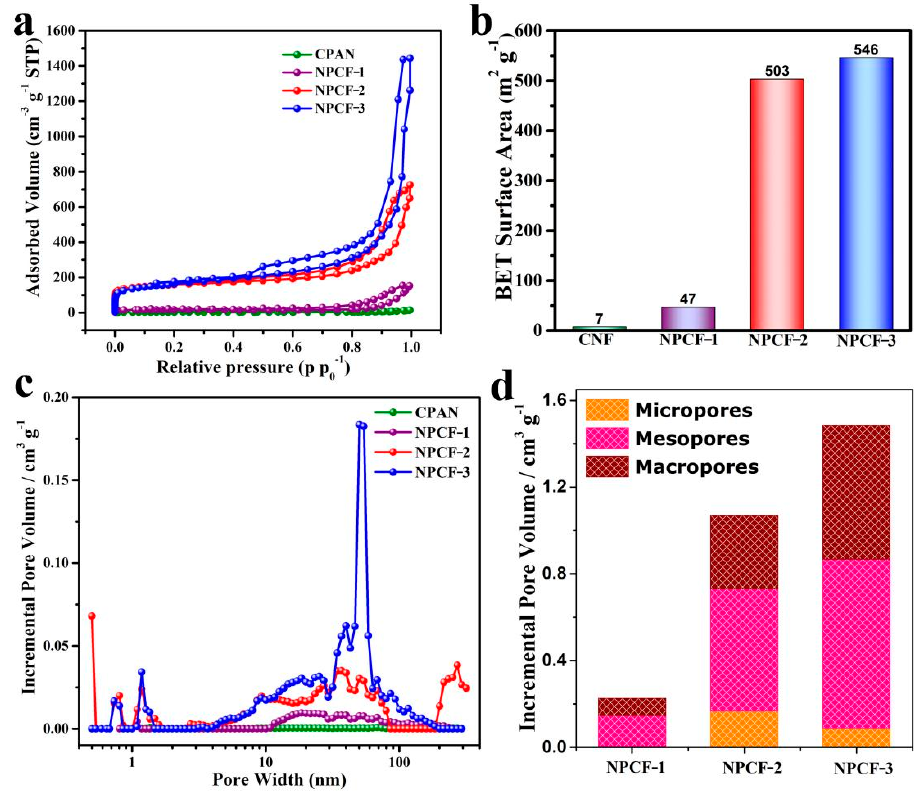
Figure 2. Nitrogen adsorption-desorption isotherms ( a ), BET surface area values ( b ) and DFT pore size distributions ( c , d ) of different NPCFs and CPAN.